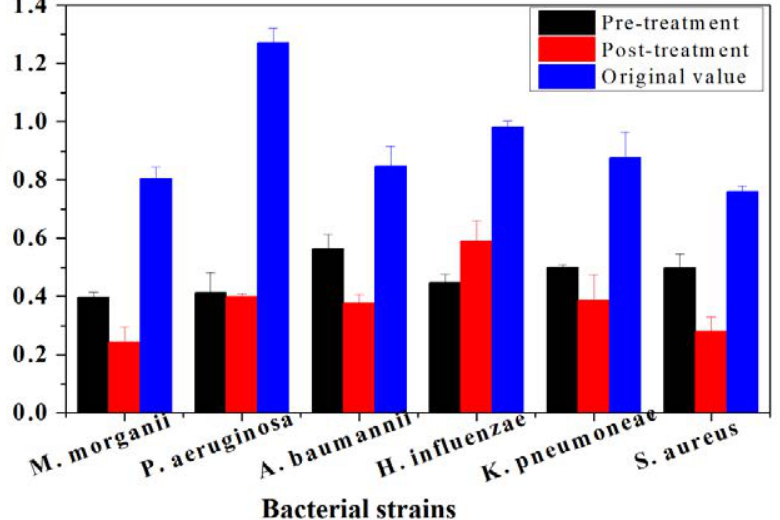
Fig. 2. Comparative analysis of biofilm growth of six bacterial strains on a microtiter plate before and after pre and post treatment by Tamarix aphylla bark. Bars represent means ± standard errors for three